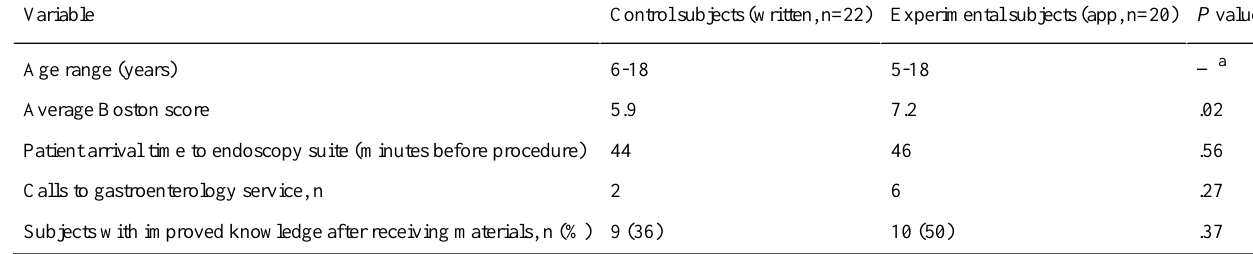
Table 1. Study results.